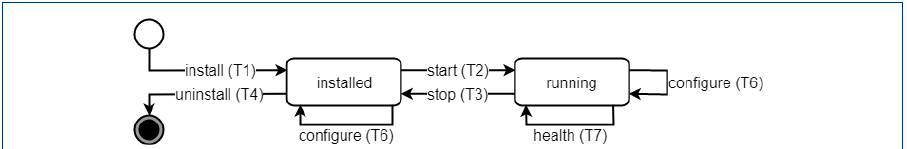
Figure 1 A simpli(cid:12)ed application lifecycle